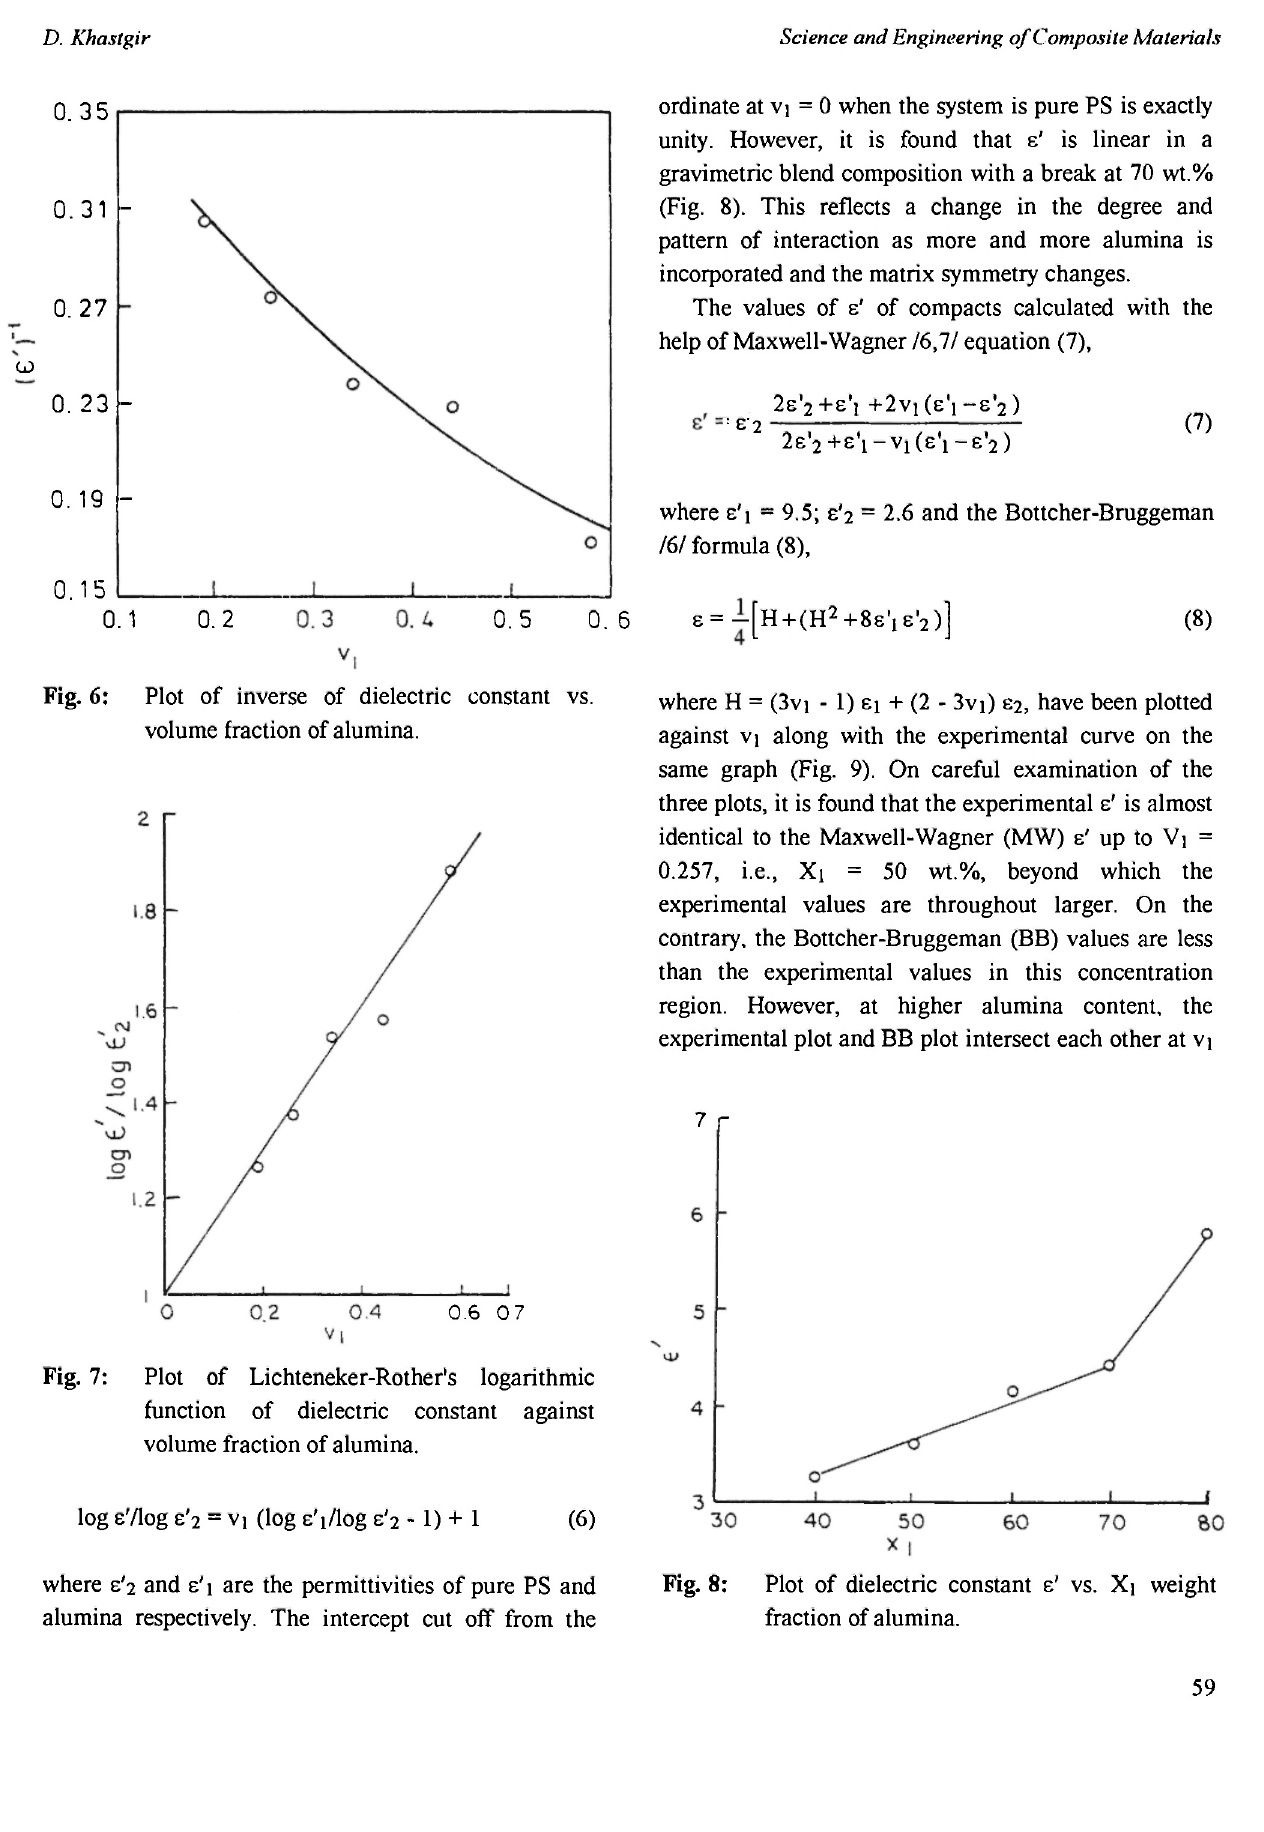
Fig. 8: Plot of dielectric constant ε' vs. Xi weight fraction of